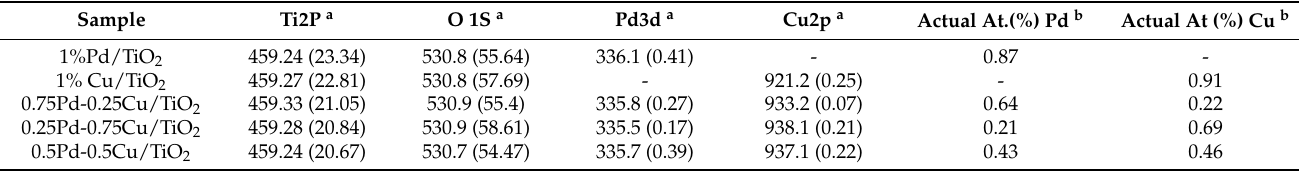
Table 1. Binding energies and surface contributions of Ti2P, O1S, Pd3d and Cu2p of and to the catalysts.